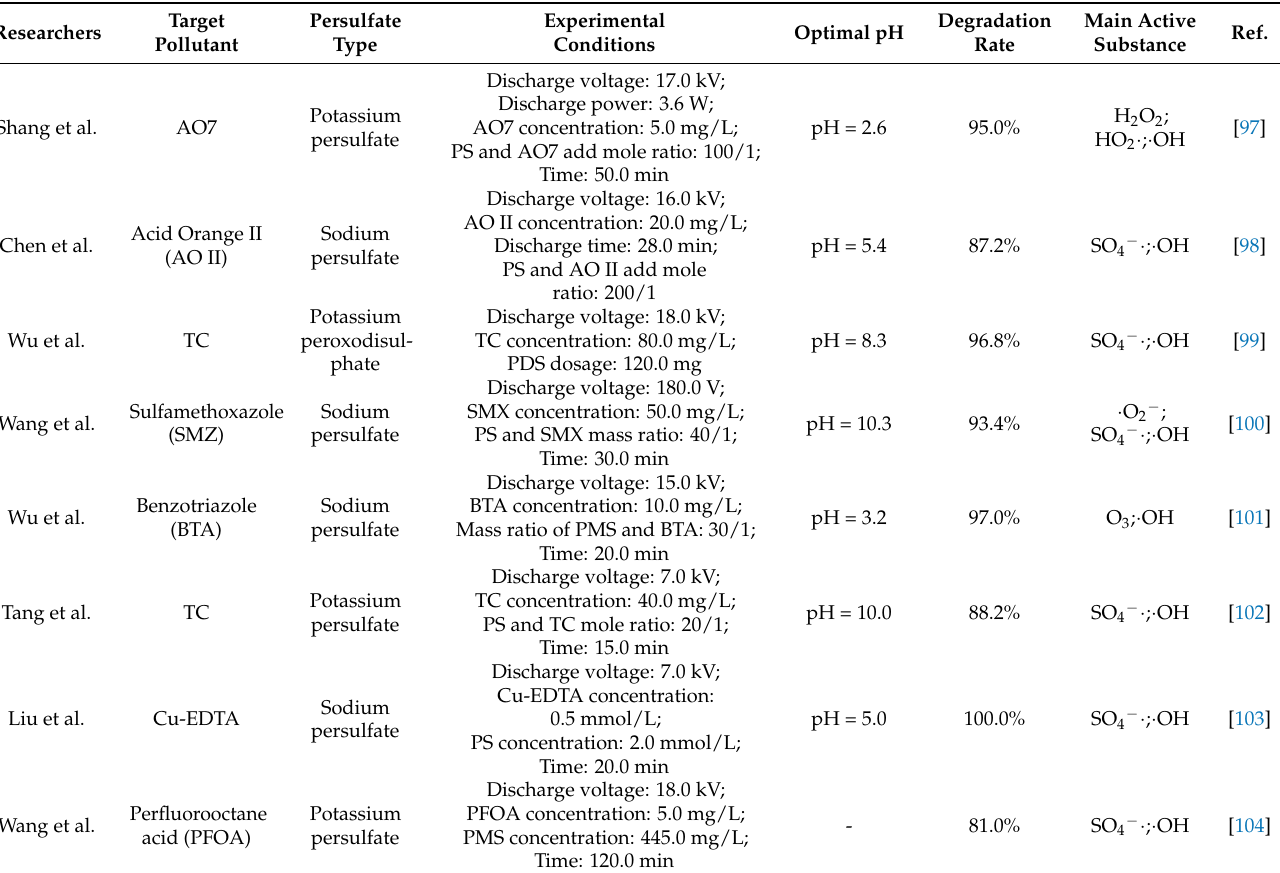
Figure 8. Mechanism of DBD coupled with PS catalyst for the degradation of organic pollutants. Table 4. Summary of DBD technologies with persulfate oxidation for the organic wastewater removal.